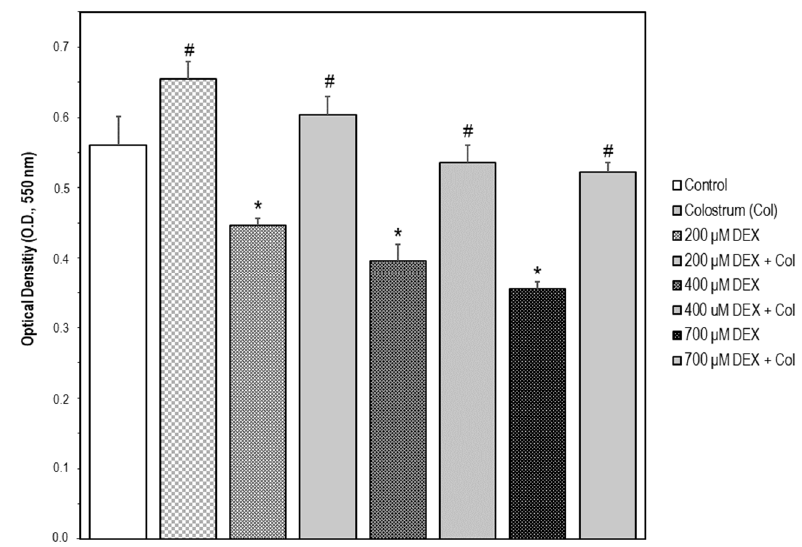
Figure 1. Cell model of neurotoxicity by SH-SY5Y cell exposure to dexamethasone (DEX). Cell viability was measured by the MTT assay. The data are expressed as the mean ± S.E.M. of three independent experiments. A set of SH-SY5Y cells were treated with DEX in a concentration range of 0–700 μ M for 48 h. Significant differences were found in optical density (OD, 550 nm) values elicited by every DEX concentration compared to the control untreated cells (Newman–Keuls test, * p < 0.05 vs . control). Another set of cells were treated with colostrum (1.0 mg/mL) for 1 h and then cell incubation continued with DEX (200, 400, or 700 μ M) for 48 h. Significant differences were found in OD values elicited by colostrum alone compared to the control untreated cells (Newman–Keuls test, # p < 0.05). Significant differences of DEX plus colostrum versus DEX-treated cells were found at any DEX concentration (Newman–Keuls test, # p < 0.05).